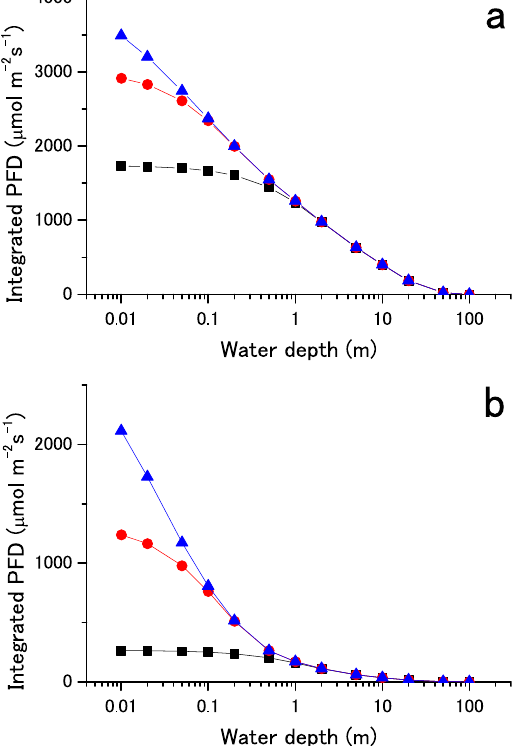
Figure 2. Light intensity changes in shallow water. Solar (panel a) and AD Leo (panel b) radiation intensities obtained for shallow water are plotted against water depth. Black squares, red circles, and blue triangles represent the integrated PFDs in the ranges of 400–700, 400–900, and 400–1,100 nm,